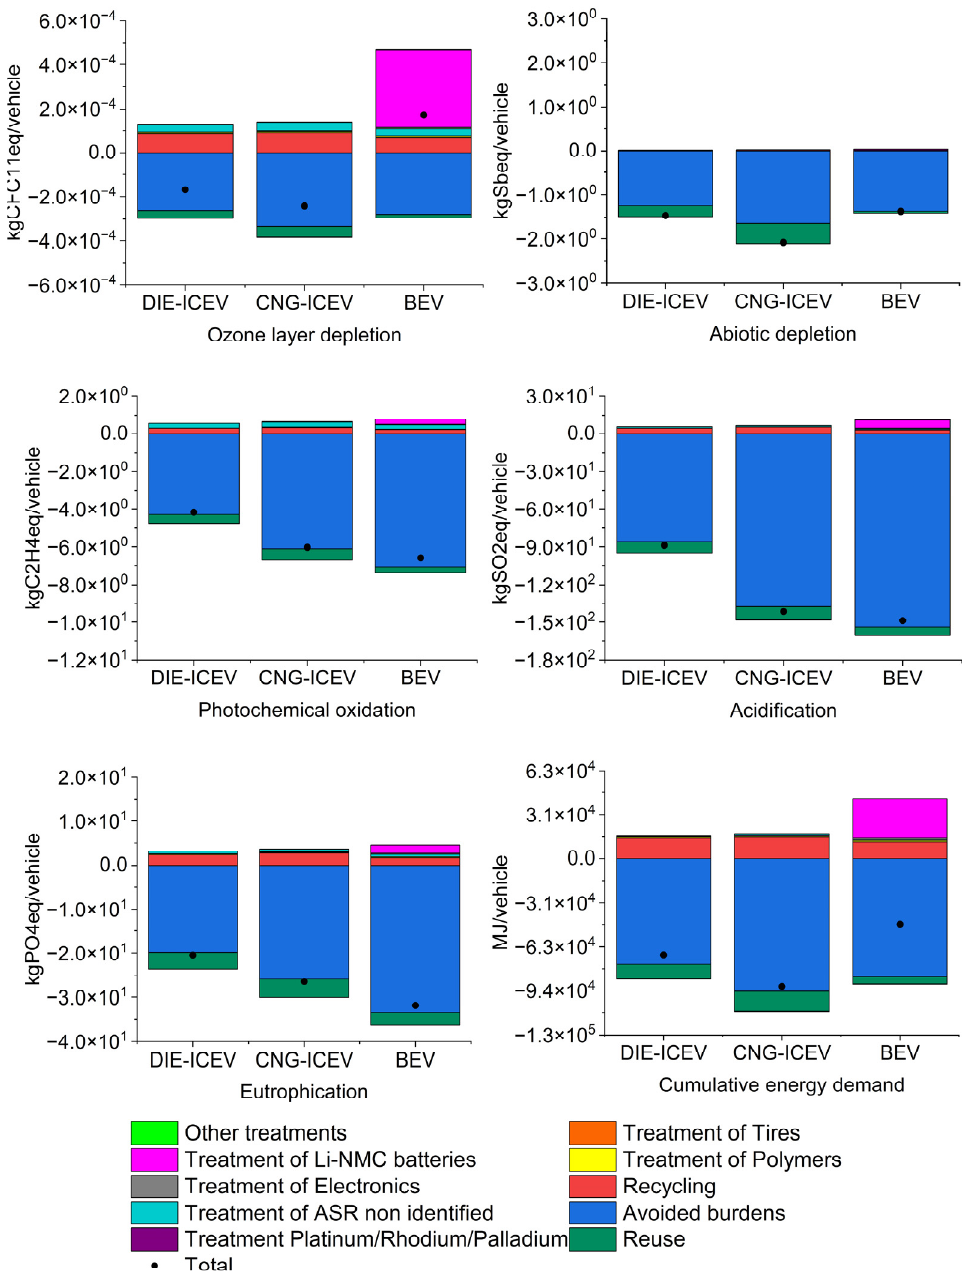
Figure 7. EoL stage environmental impacts under the avoided burden scenario for different impact categories: ozone layer depletion; abiotic depletion; photochemical oxidation; acidification; eutrophication; cumulative energy demand.